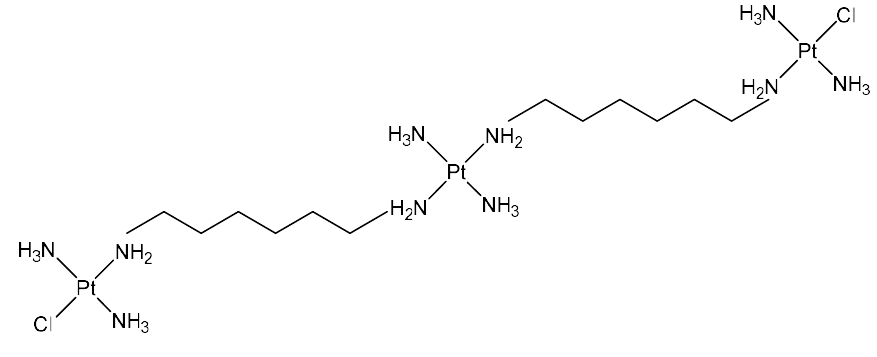
Figure 4. Structural representation of the